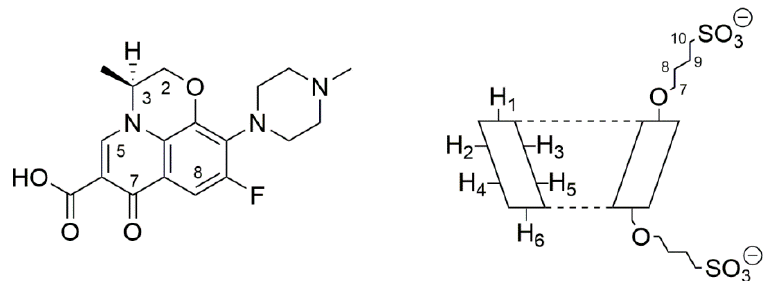
Figure 1. Molecular structure of levofloxacin (LVF) ( left ) and schematic structure of sulfobutyl-ether- β -cyclodextrin (SBE- β -CD) ( right ).